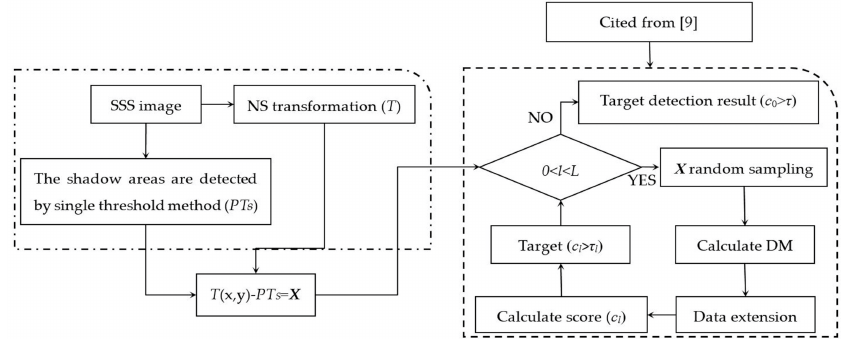
Figure 2. Flowchart of the proposed target detection algorithm (NS +